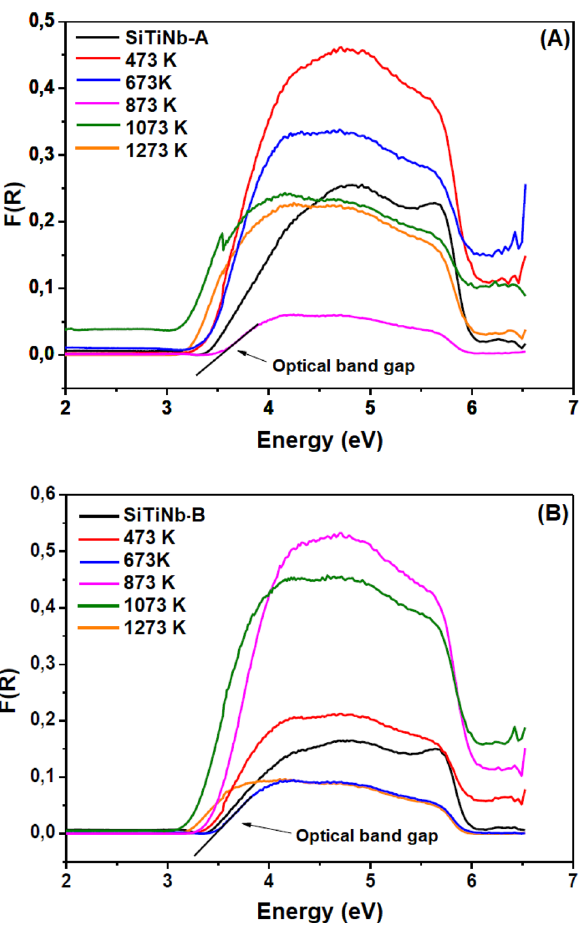
Figure 9. DRS (Kubelka–Munk function, F (R)) and extrapolation of the tangent line to obtain the optical band-gap of the SiTiNb-A (A) and SiTiNb-B (B) samples treated at different